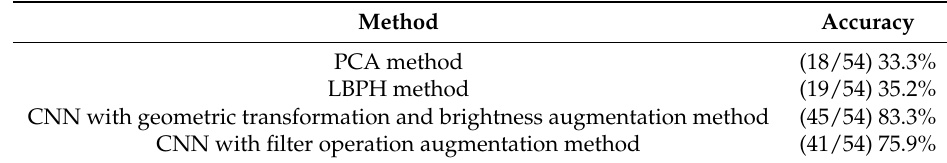
Figure 5. Training the model with different initialization methods. ( a ) Accuracy vs. Iterations on the CNN architecture. ( b ) Test loss vs. Iterations on the CNN architecture. Table 4. Recognition performance with different